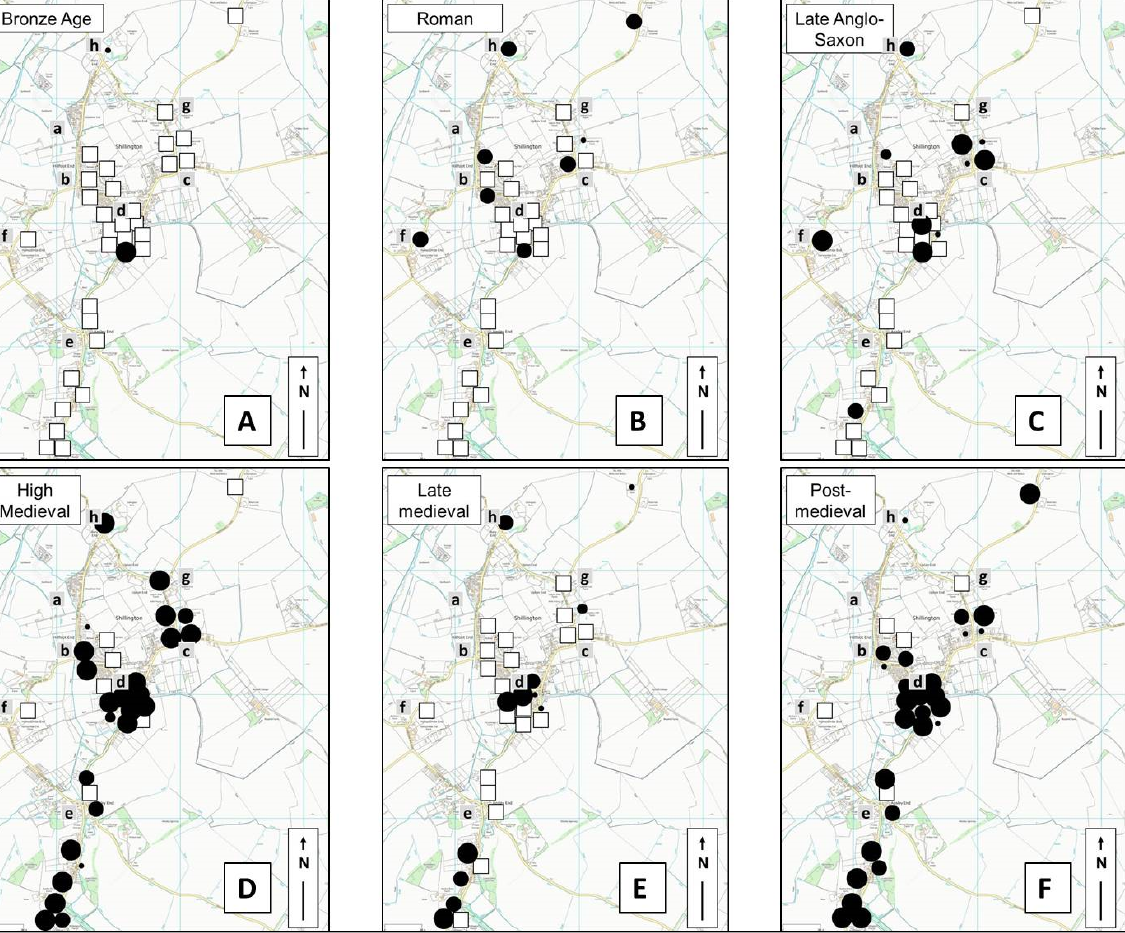
Figure 3. Pottery from test pits excavated in Shillington. (A) Bronze Age; (B) Roman; (C) Late Anglo-Saxon; (D) High medieval; (E) Late medieval; and (F)